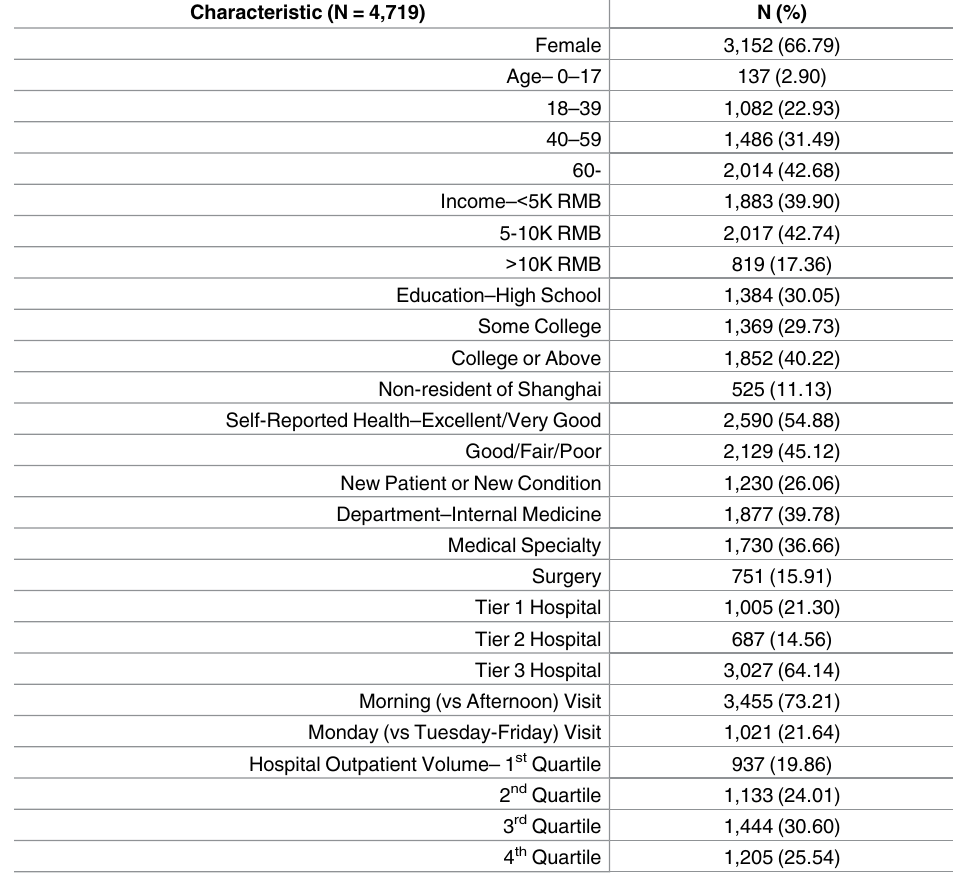
Table 3. Descriptive statistics of outpatients at public hospitals in Shanghai: General